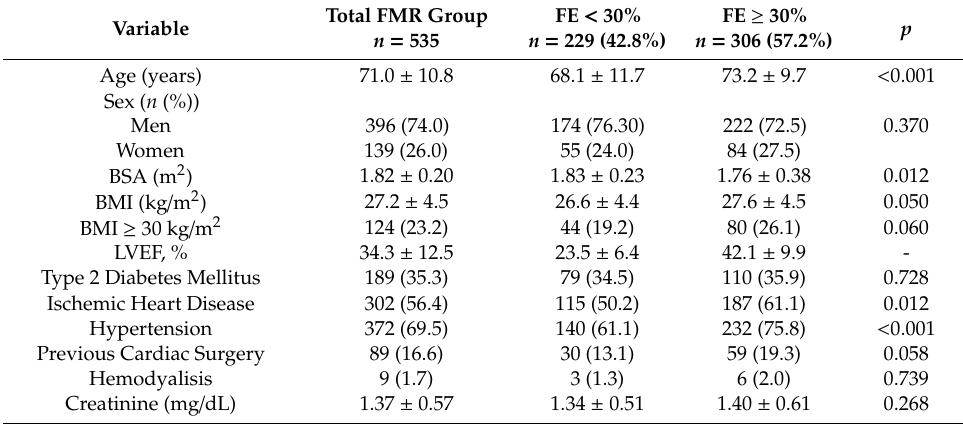
Table 1. Baseline characteristics in the global series and among both groups according to the left ventricular ejection fraction (LVEF).